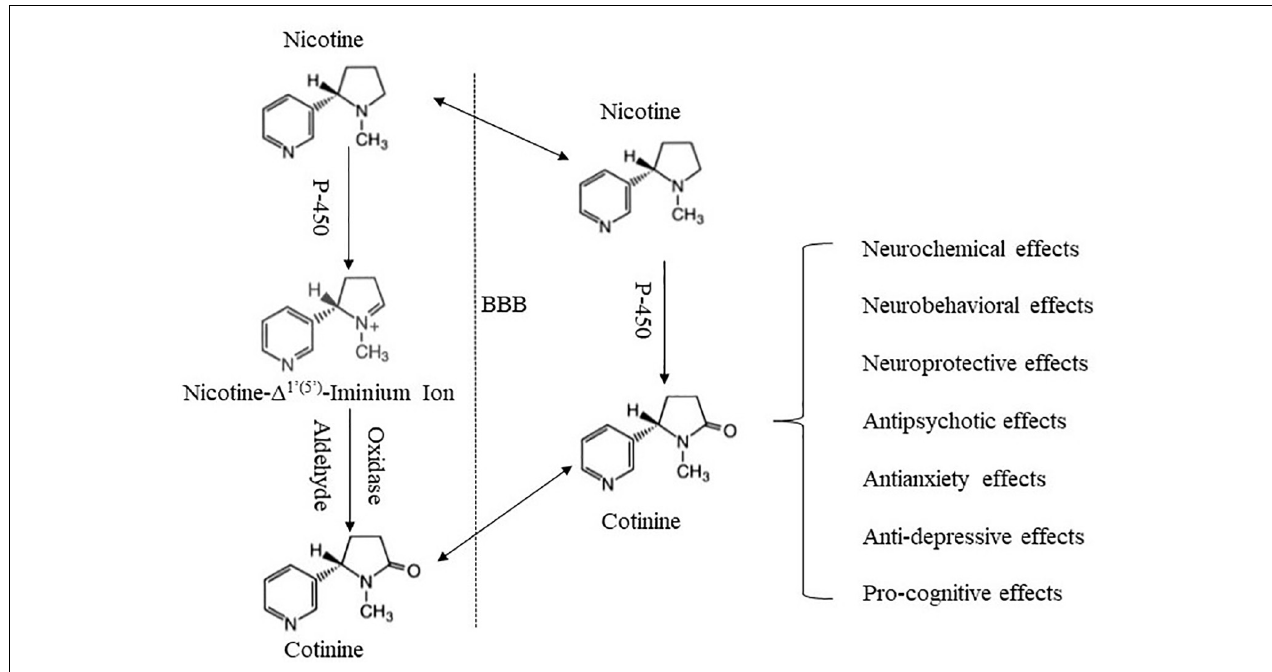
FIGURE 1 | Schematic summary of cotinine formation and its major effects. Cotinine is formed mainly in the periphery via an enzyme-mediated process. Following its formation, cotinine penetrates the BBB and enters the brain. Cotinine in the brain may also be derived from in situ metabolism of nicotine. Cotinine then interacts with the brain to produce a variety of